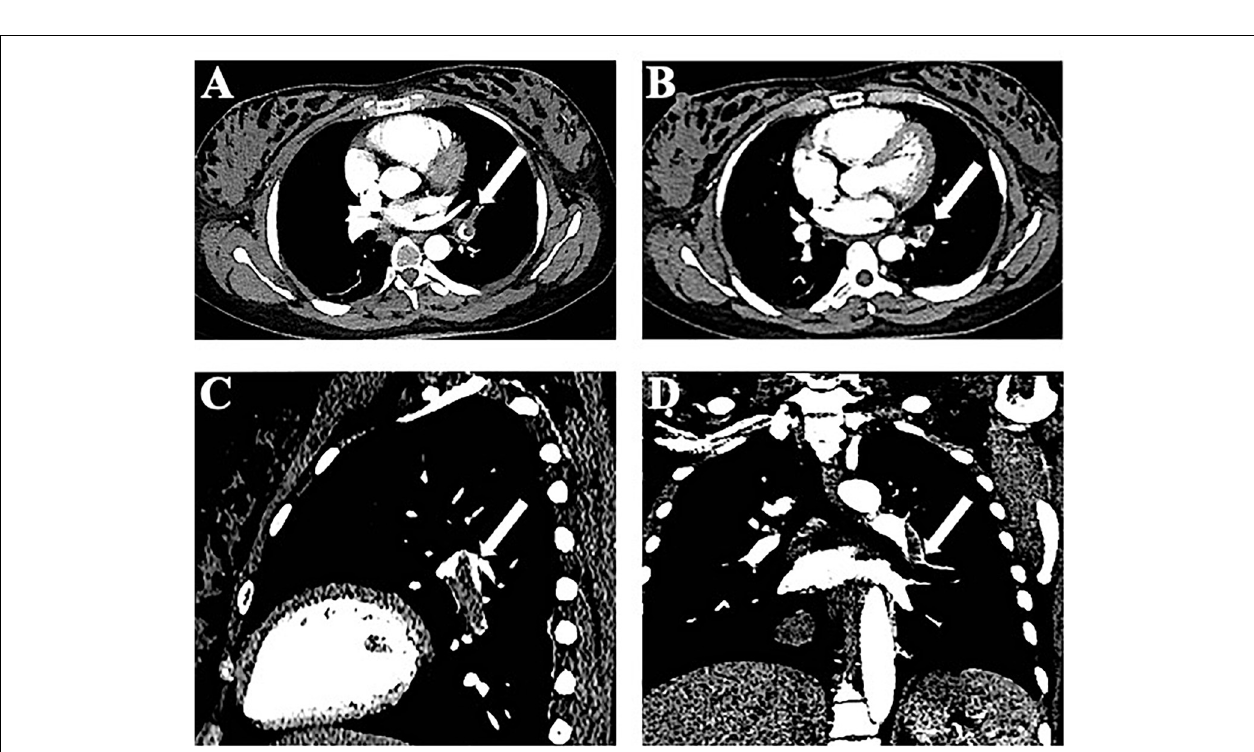
FIGURE 2 | Imaging of computed tomography pulmonary angiography. (A) Computed tomography pulmonary angiography (CTPA) shows an embolism at the left pulmonary artery (axial images). (B) CTPA shows right pulmonary artery branch embolism. (C,D) Sagittal and coronal images.